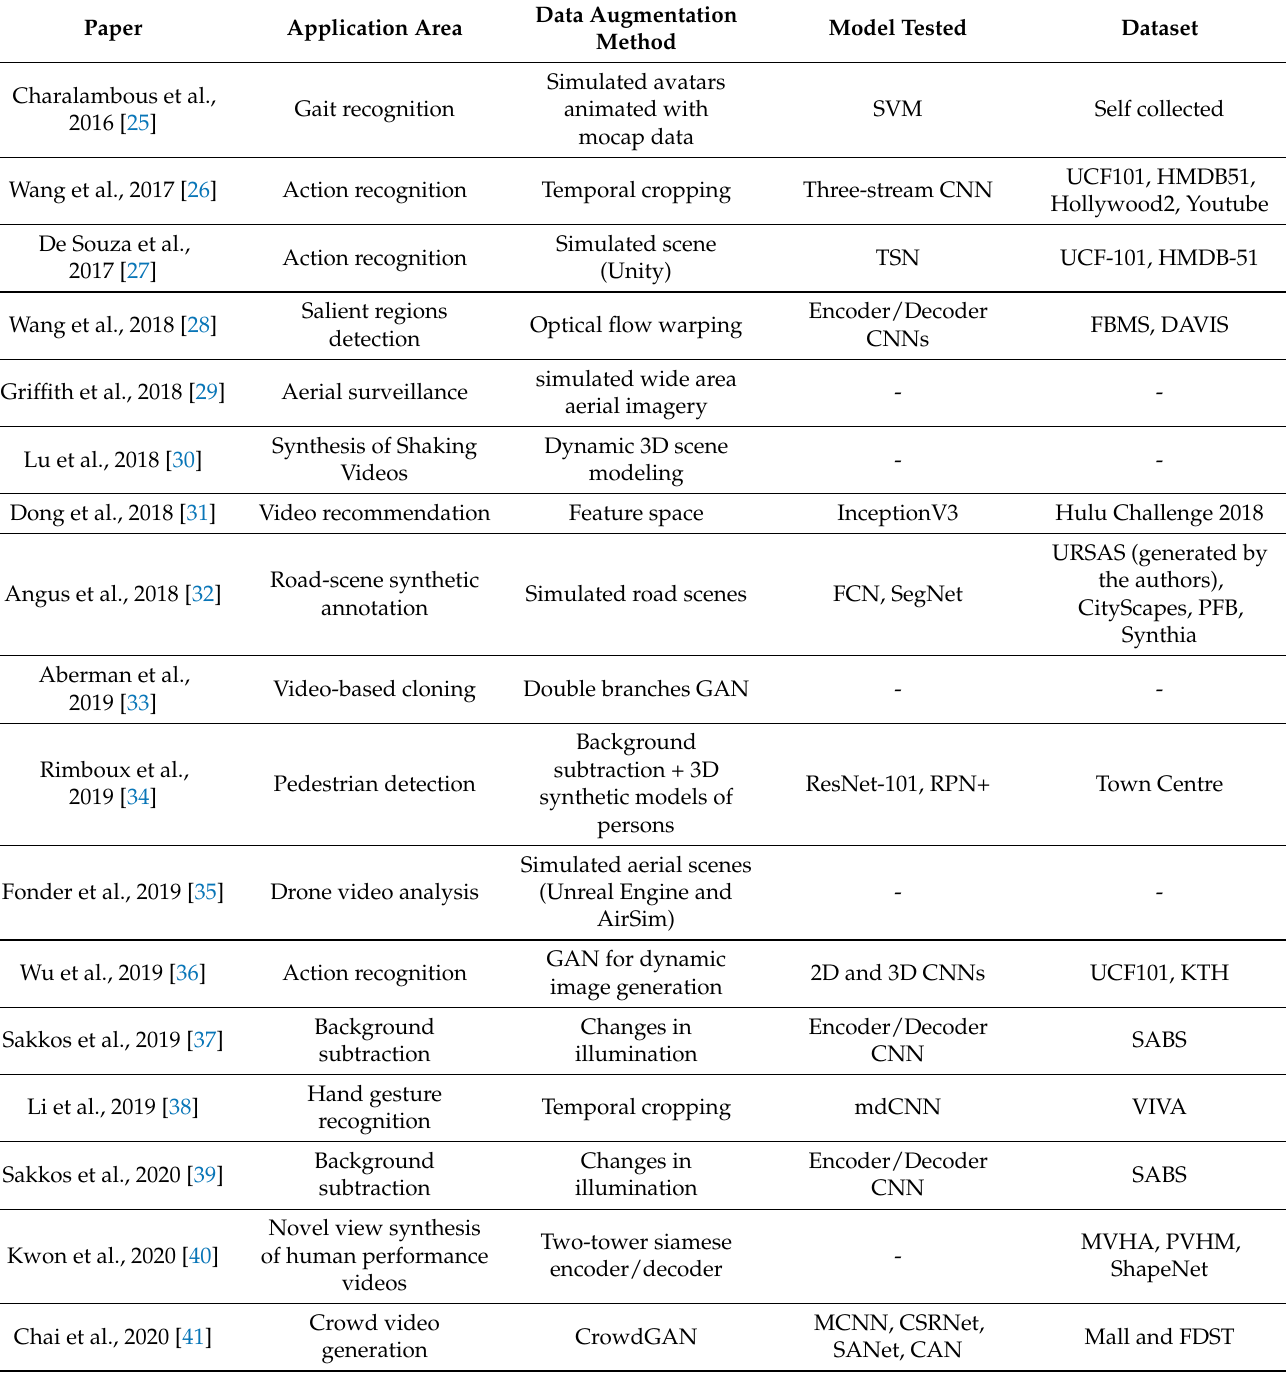
Table 1. List of the reviewed papers part 1. The first 20 papers ordered by year of publication. Please read the analysis of the papers in Section 3 for a better understanding of the